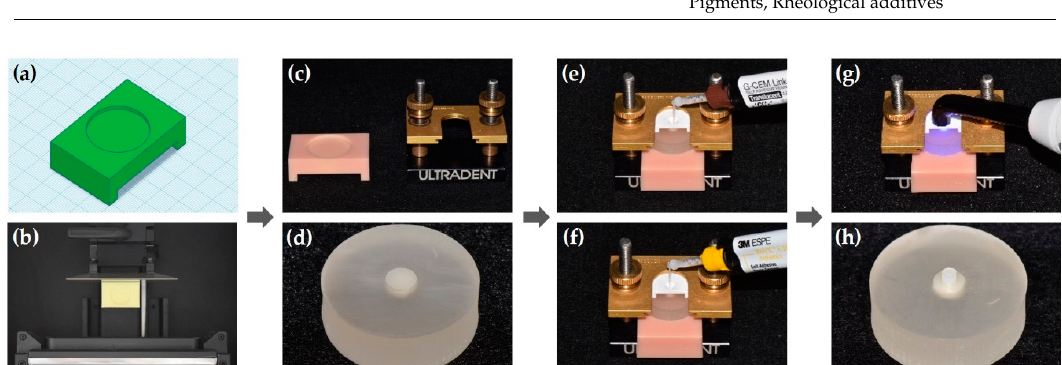
Figure 3. A series of the bonding process. ( a ) CAD data and ( b ) 3D printing for the positioning stand; ( c ) 3D printed positioning stand and bonding clamp; ( d ) Disc-shaped Y-TZP specimen embedded in acrylic resin; ( e ) Apply G-CEM LinkAce and ( f ) RelyX U200 to the Y-TZP surface using a plastic jig; ( g ) Light curing with an LED curing light; ( h ) Disc-shaped Y-TZP specimen bonded with the resin